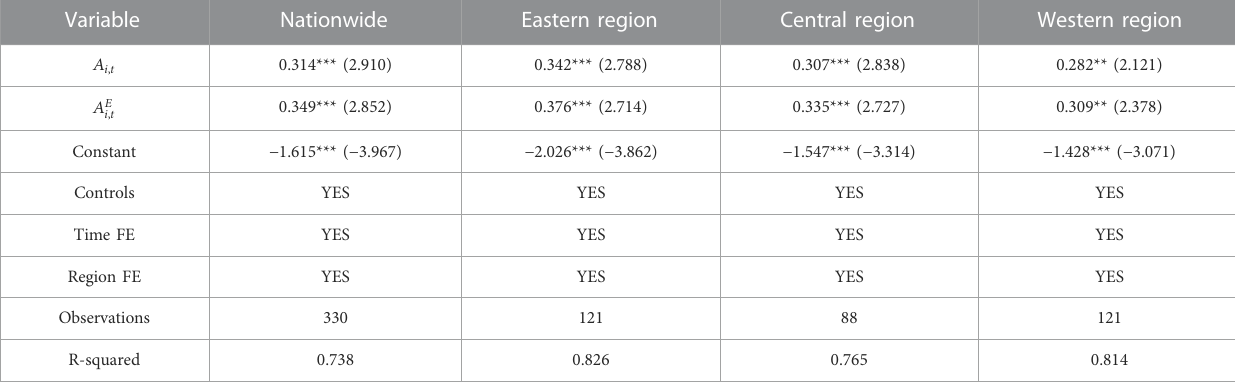
TABLE 8 Regression results of the impact of technical progress on carbon productivity in China ’ s service industry from 2009 to